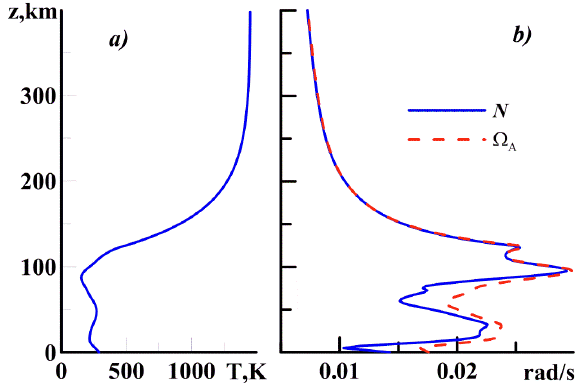
Figure 1. An example of vertical profile of the background temperature [28] in July at latitude 50 ◦ N ( a ) and respective profiles of the Brunt–Vaisala N and acoustic cutoff Ω A frequencies ( b ) given by Equation